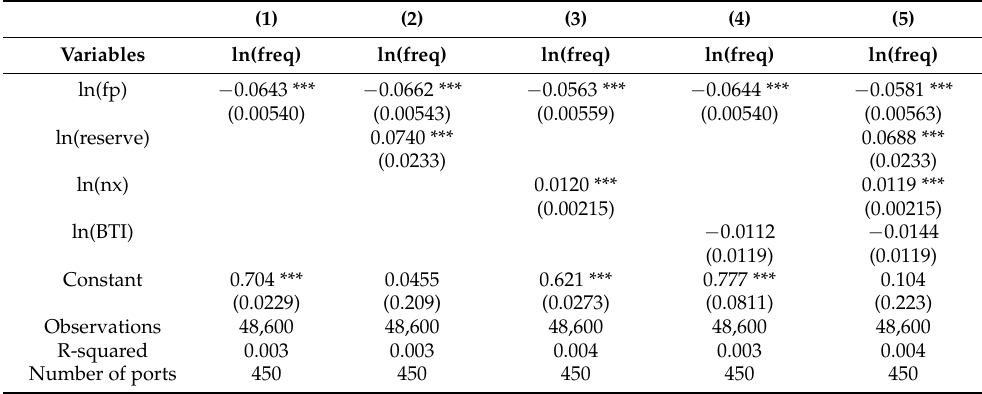
Table 7. Robustness test (freq): from 2011 to